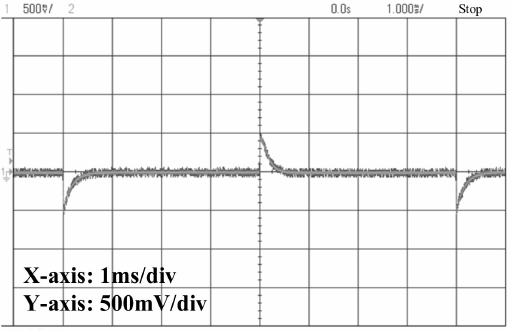
Figure 12. The output voltage waveform under load-step transient from 0.5 A to half